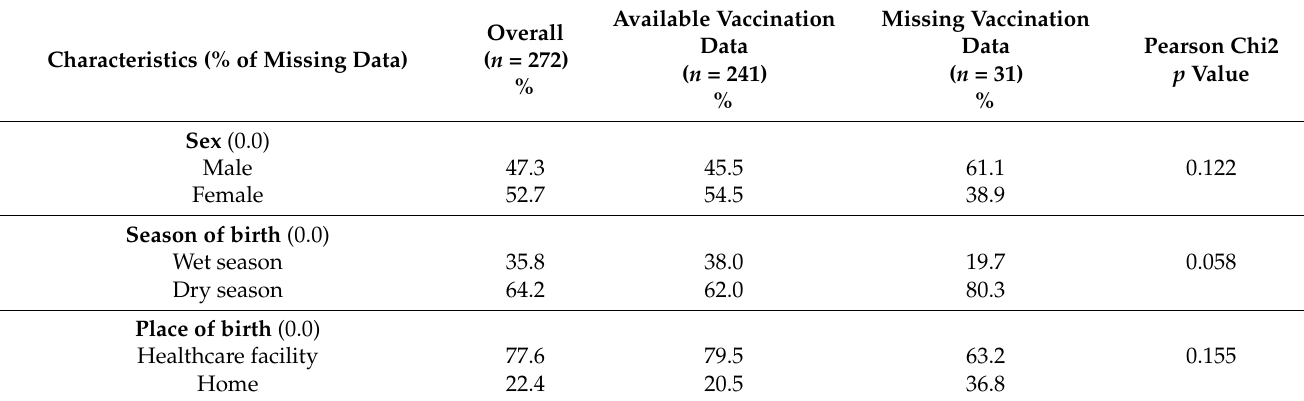
Table 1. Characteristics of children born after 2016 participating in the ANRS 12356 AmBASS survey and comparison between those with available vaccination data ( n = 241) and those with missing vaccination data ( n = 31), using weighted and calibrated